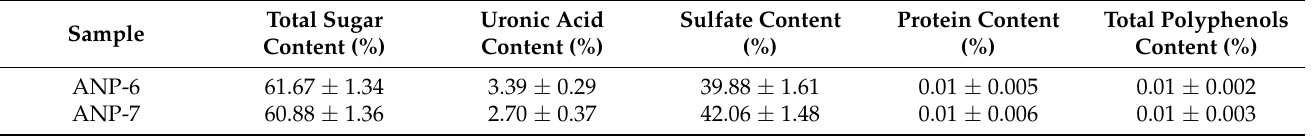
Table 1. Chemical compositions of ANP-6 and